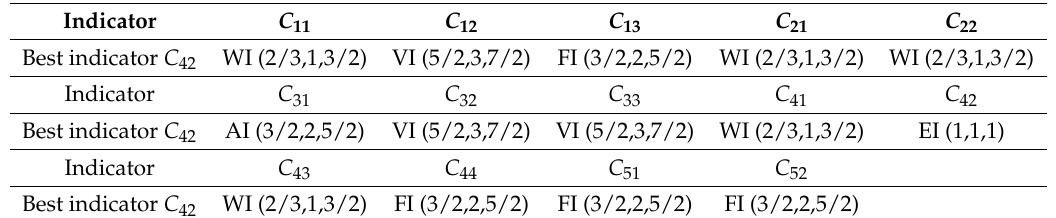
Table 3. Fuzzy rating of the best indicator compared with each indicator.